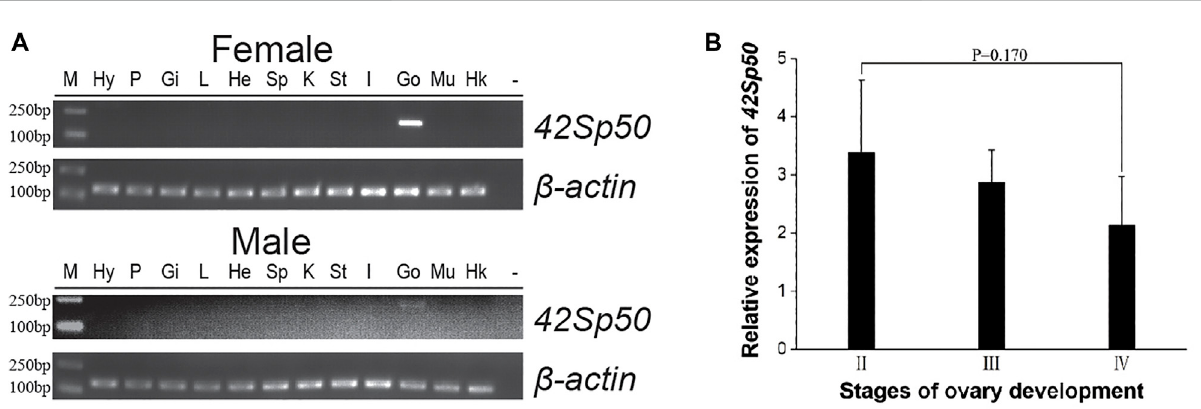
FIGURE 4 Tissue distribution and expressionof 42Sp50 mRNA at different gonad developmental phases. (A) Tissue distribution of 42Sp50 in spotted scat. ThePCRproductsforspottedscat 42Sp50 and β -actin were183 bpand145 bp,respectively.Hy,hypothalamus;P,pituitary;Gi,gill;L,liver;He,heart; Sp, spleen; K, kidney; St,stomach; I,intestines; Go, gonad; Mu, muscle; “ − ” , negative control; Marker, DS ™ 2000. (B) The expressionof 42Sp50 inthe ovary at different development stages in spotted scat using qRT-PCR. Data are presented as mean ± SEM ( n = 3).